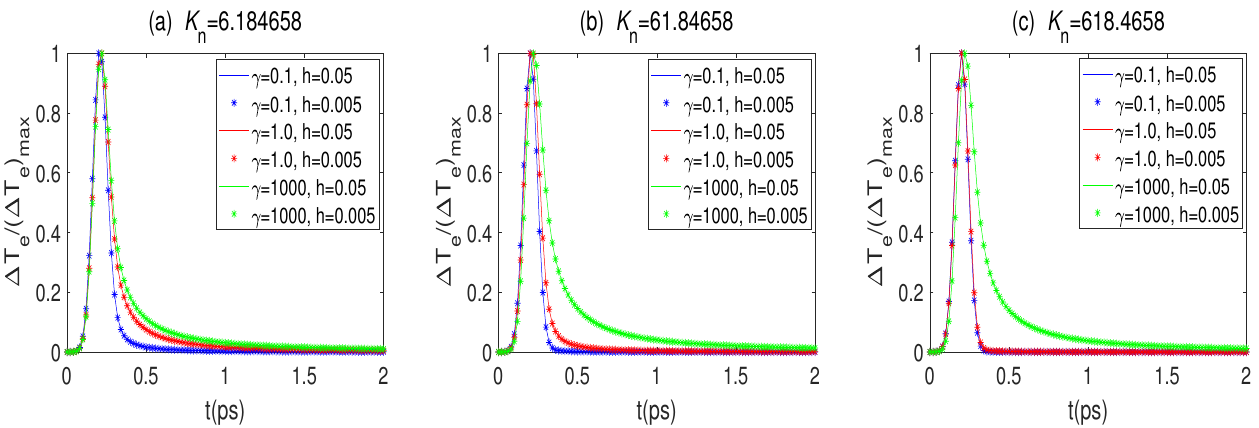
Figure 6. Changes in electron temperature ∆ T e / ( ∆ T e ) max and various K n , γ , and ( α , β ) = ( 0.6,0.4 ) .